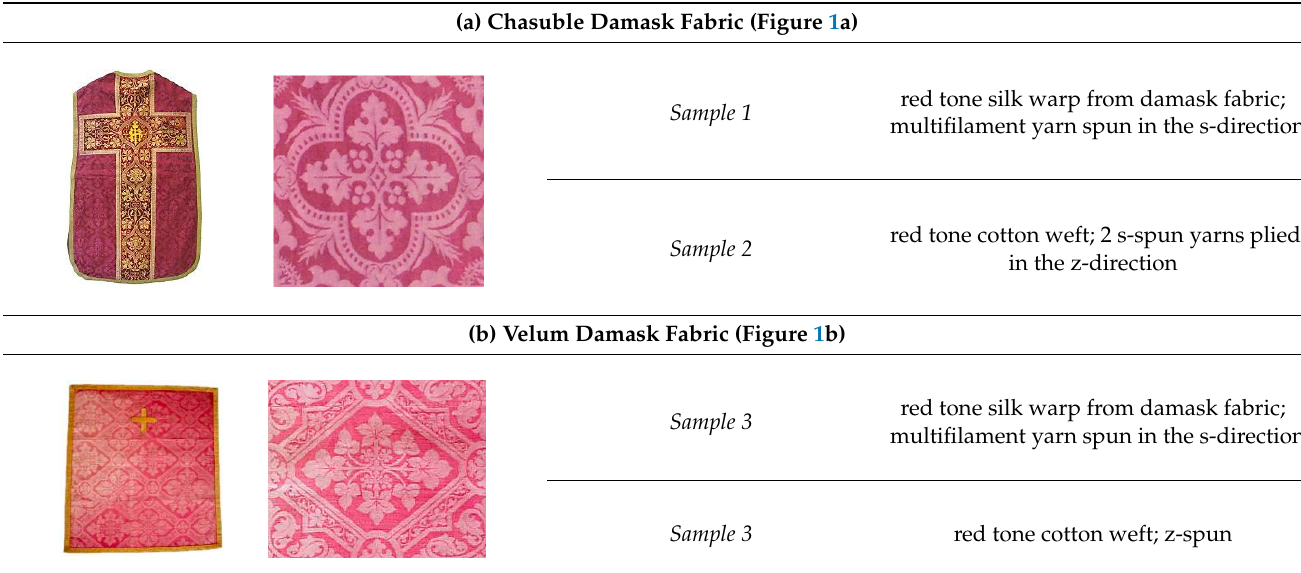
Table 1. Samples taken from the main fabric of chasuble and velum.